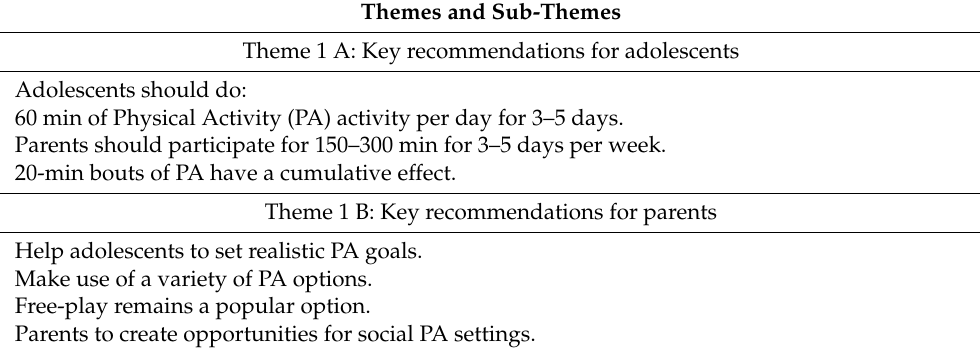
Table 1. Themes and sub-themes in a framework for